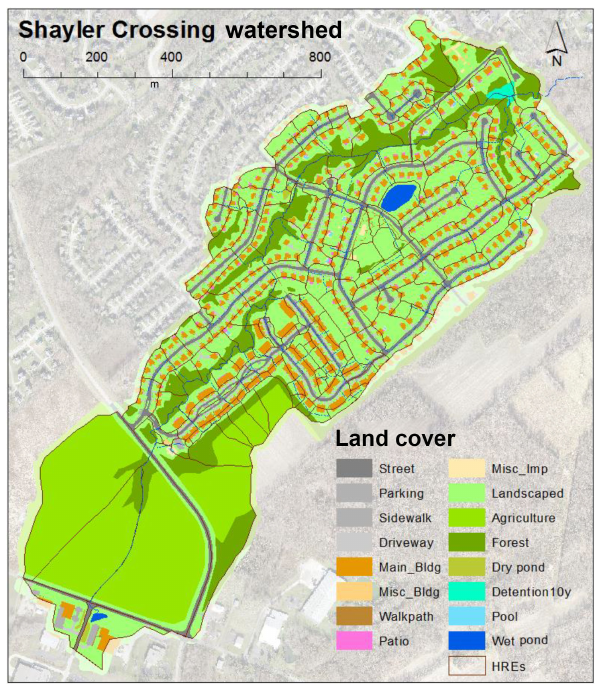
Figure 4. Detailed spatial representation of the Shayler Crossing